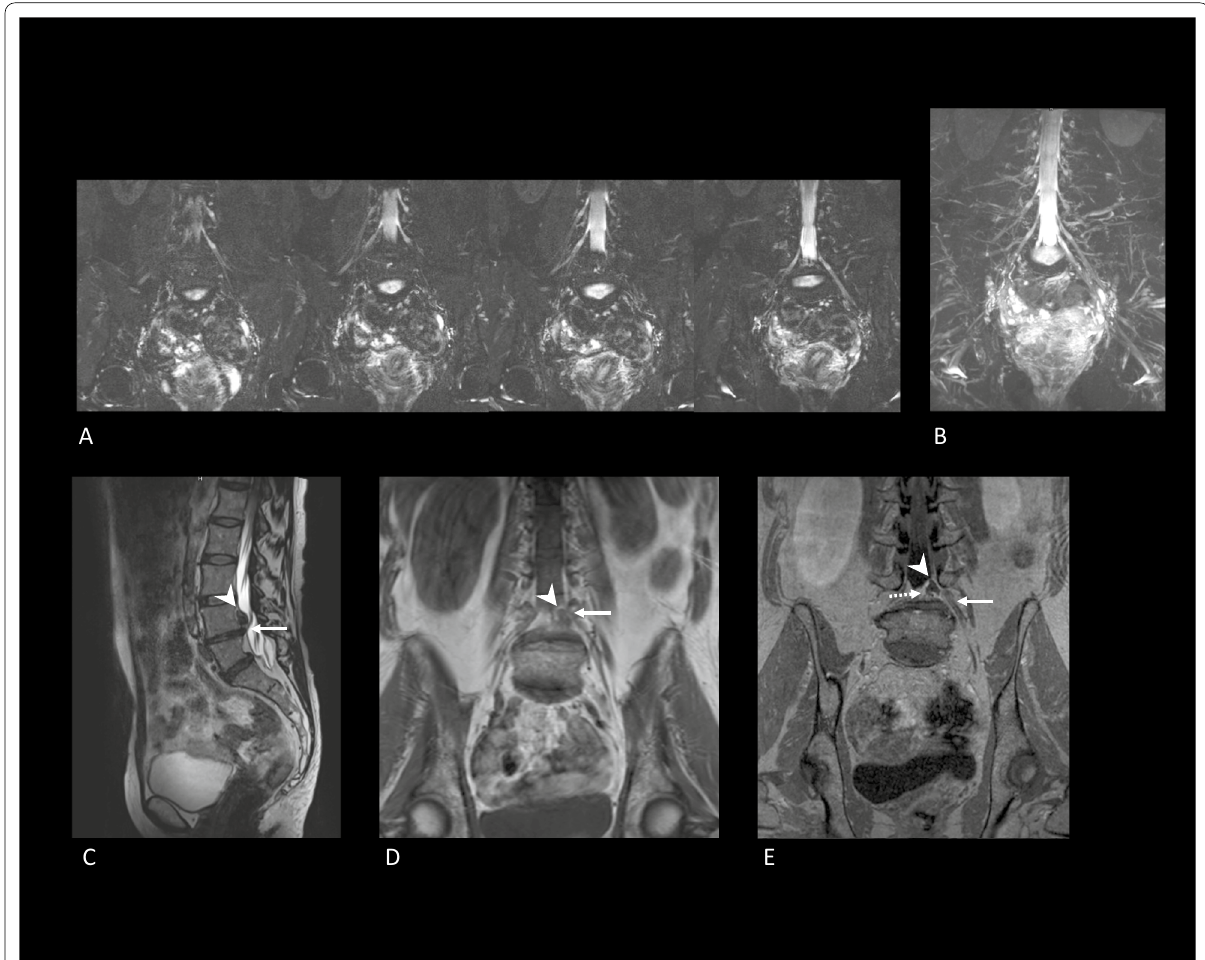
Fig. 10 MR neurography examination of two FBBS patients. A Subsequent coronal 3D short tau inversion recovery sequence (3D STIR) images of one patient with no abnormalities. B Maximum-intensity projection of the 3D STIR images of the same patient (as depicted in A ) showing no abnormalities of the lumbar plexus. C Sagittal T2-weighted MRI of a different patient showing a disk herniation occupying the left subarticular zone at level L4–L5 (white arrowhead). The white arrow depicts the coursing spinal nerve L4 on the left. D Coronal T1-weighted MRI of the same patient (as depicted in C , E ) showing the disk herniation (white arrowhead) and left L4 spinal nerve (white arrow). E Coronal T1-weighted post-contrast MRI showing enhancing tissue (white dotted arrow) surrounding the disk herniation (white arrowhead). In addition, subtle perineural enhancement of the left L4 spinal nerve (white arrow) can be